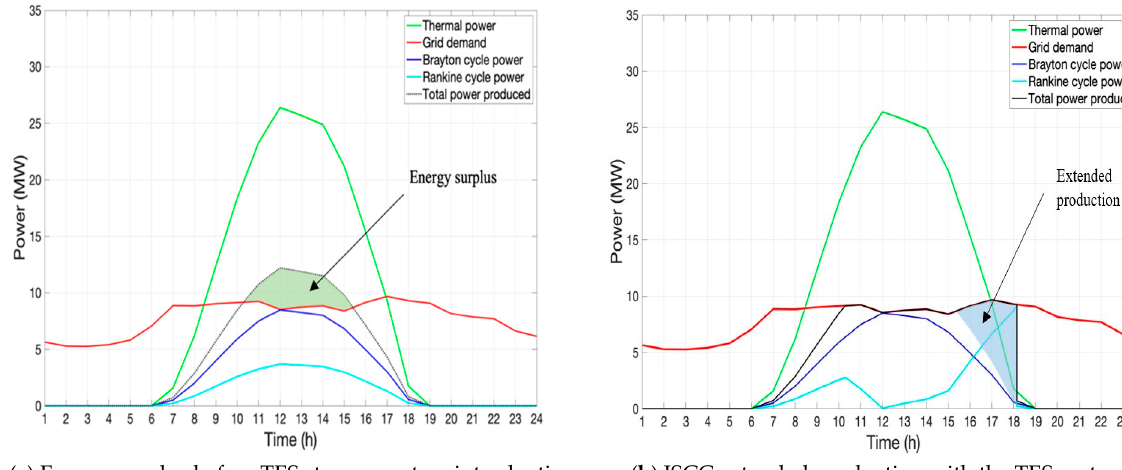
Figure 5. Hourly dispatch operation of the ISCC power plant with TES system (21st of June). According to Figure 5a, the grid demand curve (red series) can be supplied by the combined production of the Brayton topping cycle (dark blue series) and the Rankine bottoming cycle (light blue series). This combined production (dashed black series) can cover grid demand between 10:18 and 15:24, which represents 21.32% of the plant utility factor. As it can be observed, the combined operation of Brayton and Rankine cycles results in an electricity surplus production (shaded area) compared to the requested grid demand. In that event, surplus electricity could not be injected into the grid, which would be translated into missed electrical production. To overcome this situation, active loading of the molten salts thermal energy storage system (Approach A) is proposed and represented Figure 5b. As it can be noticed, once the TES system is introduced, the Rankine bottoming cycle adapts its production (varying water flow through the HRSG) to the exact electricity required to cover grid demand. In this situation, grid demand can be fully covered between 10:18 and 18:09, which results in a plant utility factor of 32.71%.